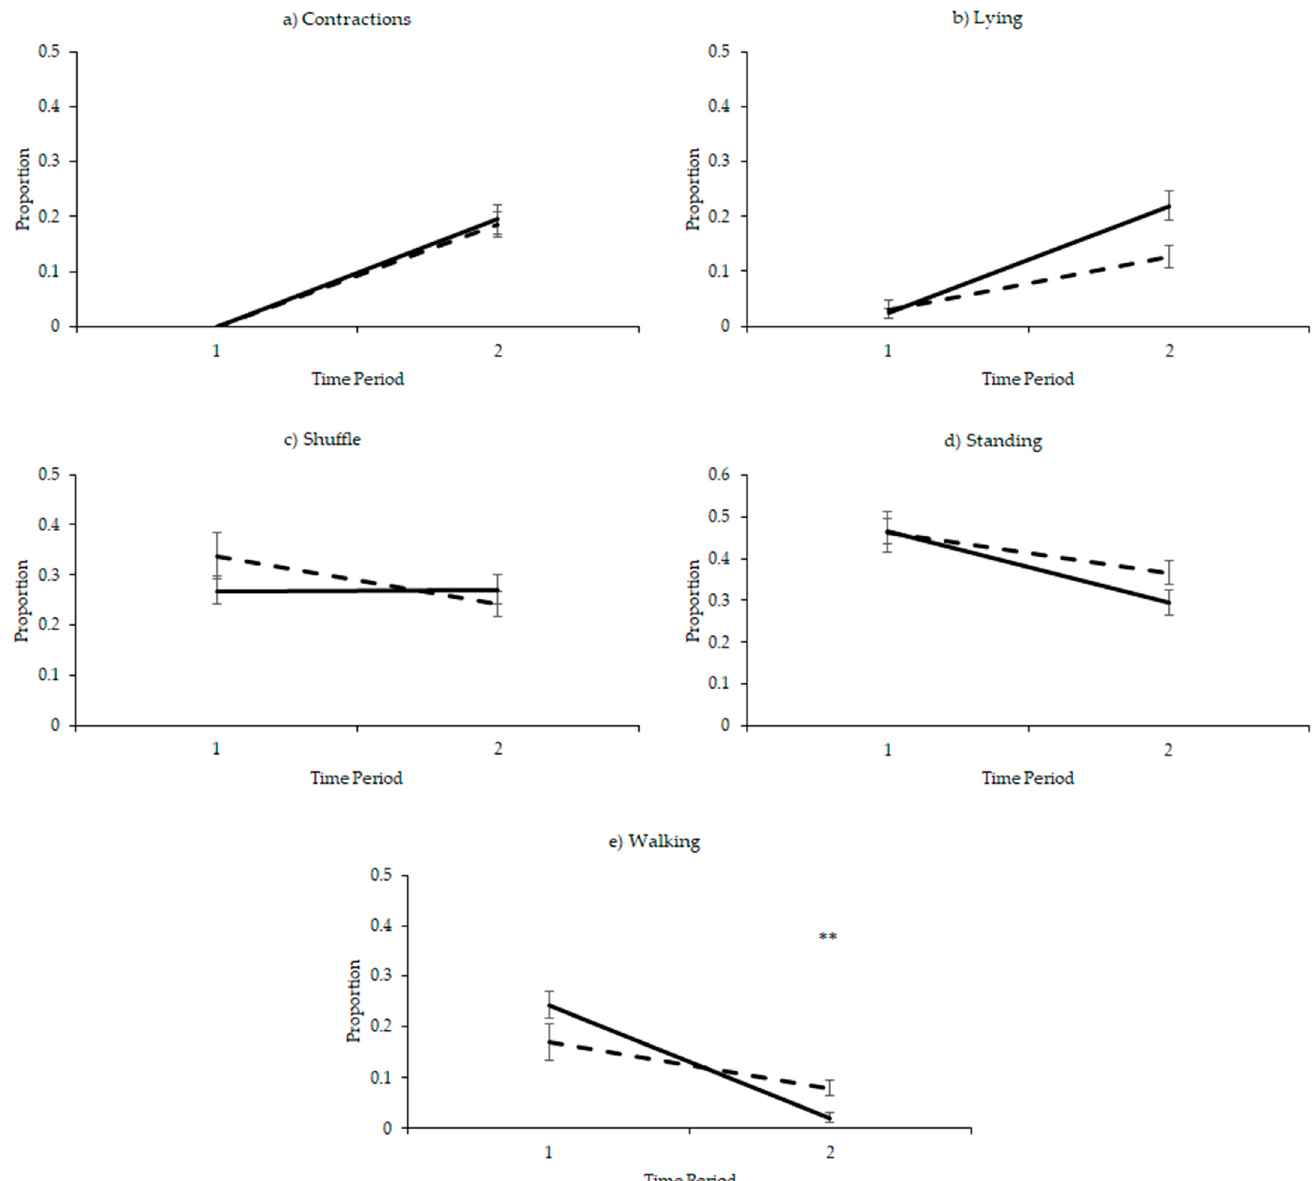
Figure 4. Predicted mean (± SEM) proportion of observations that were ( a ) contractions, ( b ) lying, ( c ) shuffling, ( d ) standing and ( e ) walking behavior for assisted (dashed line) or unassisted (solid line) lambing in time Periods 1 or 2, with Period 2 ending with the lambing event. ** p < 0.01.